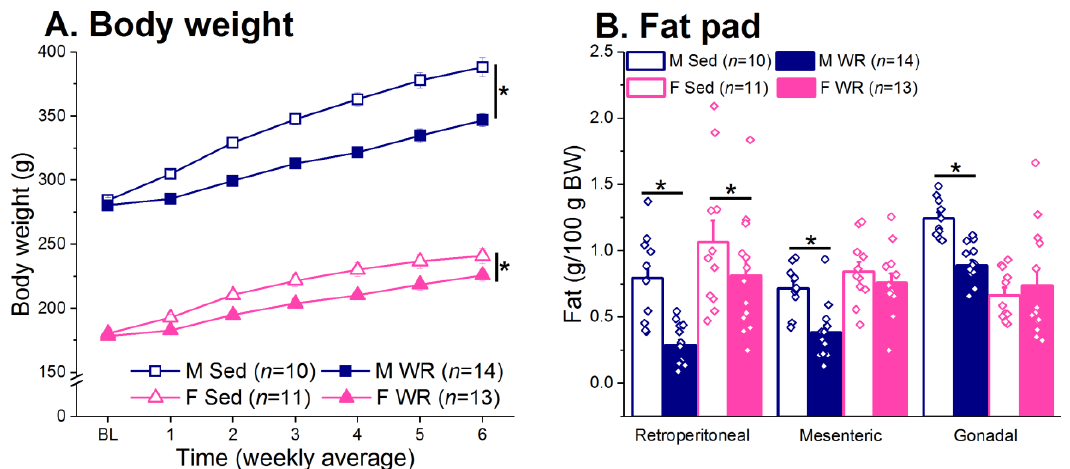
Figure 5. Body weight and fat composition. ( A ) Exercise suppressed body weight in both sexes; however, this effect was more pronounced in males. * Sed vs. WR, p < 0.05. ( B ) Exercise led to decreased retroperitoneal, mesenteric, and gonadal fat in males and decreased only retroperitoneal adiposity in females. * Sed vs. WR, p < 0.05.